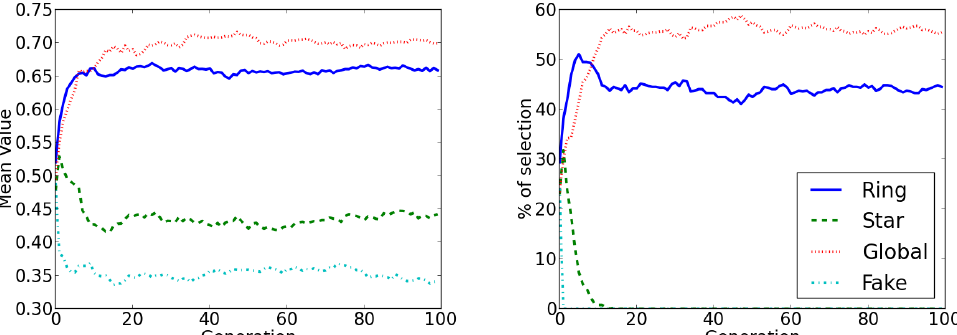
Figure A4. Average values and selection percentages of the genes representing the four topologies versus number of EMOPaT generations. Results averaged over 64 individuals in 10 runs.